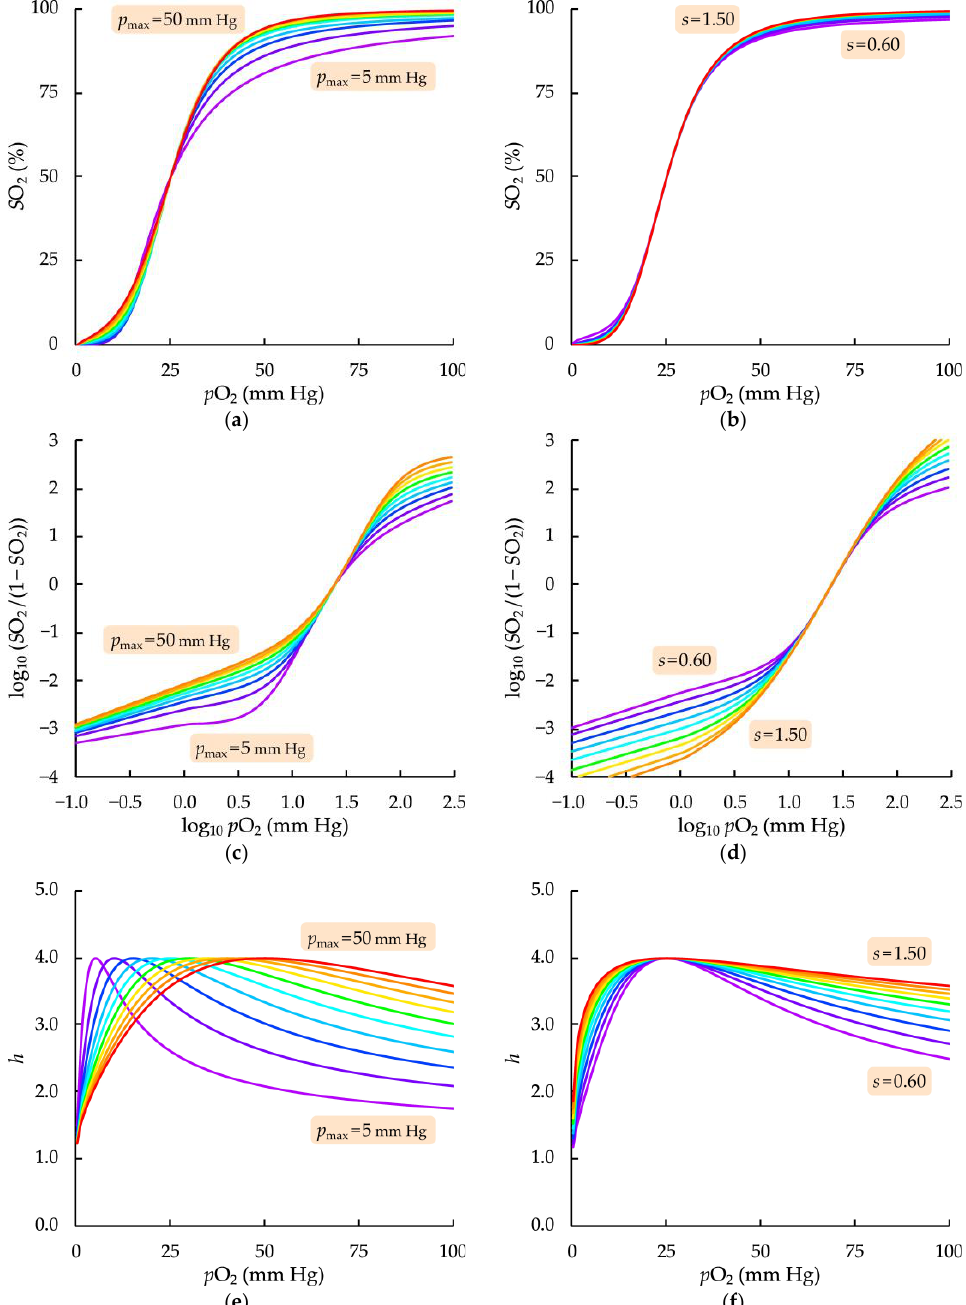
Figure 4. Dependencies with respect to oxygen partial pressure for oxyhemoglobin dissociation (left panels), and for the Hill coefficient (right panels); ( a , b ) with constant parameters: p 50 , h max , s and variable p max ; ( c , d ) with constant parameters: p 50 , p max , h max , and variable s ; ( e , f ) axes: p O 2 , partial pressure of oxygen; S O 2 , oxygen saturation; h , Hill coefficient.